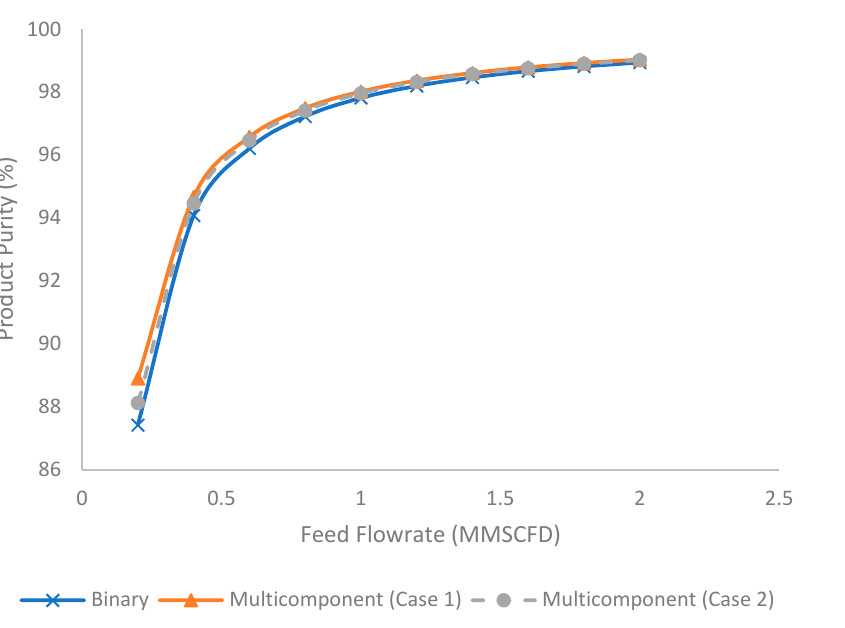
Figure 10. Evolution of hydrocarbon loss (%) under different feed flow rates for binary and multi- component systems.